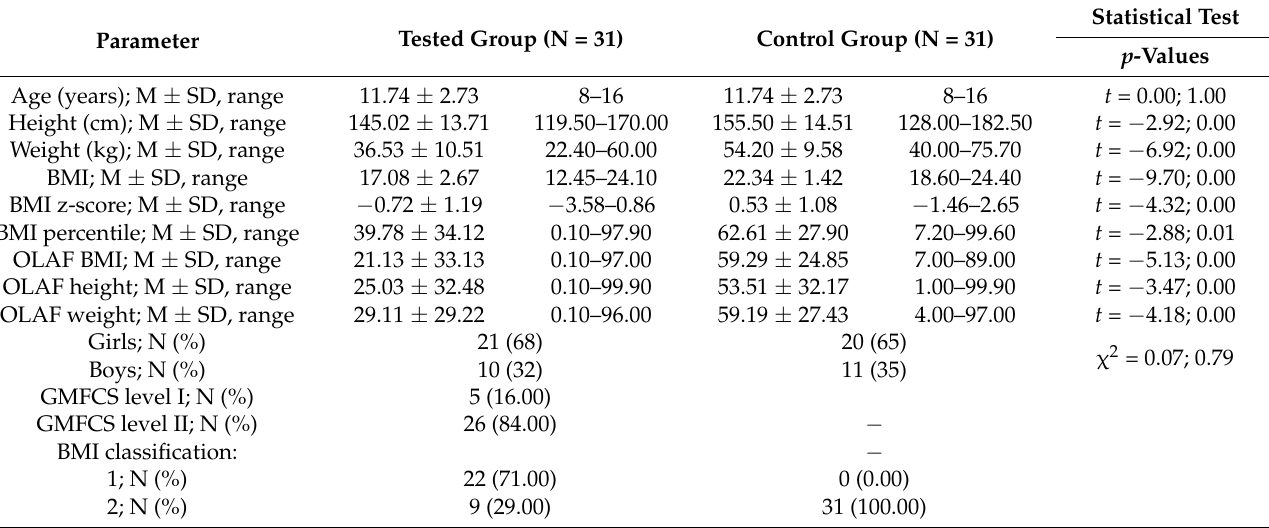
Table 2. Demographic and anthropometric data of the tested and control groups.